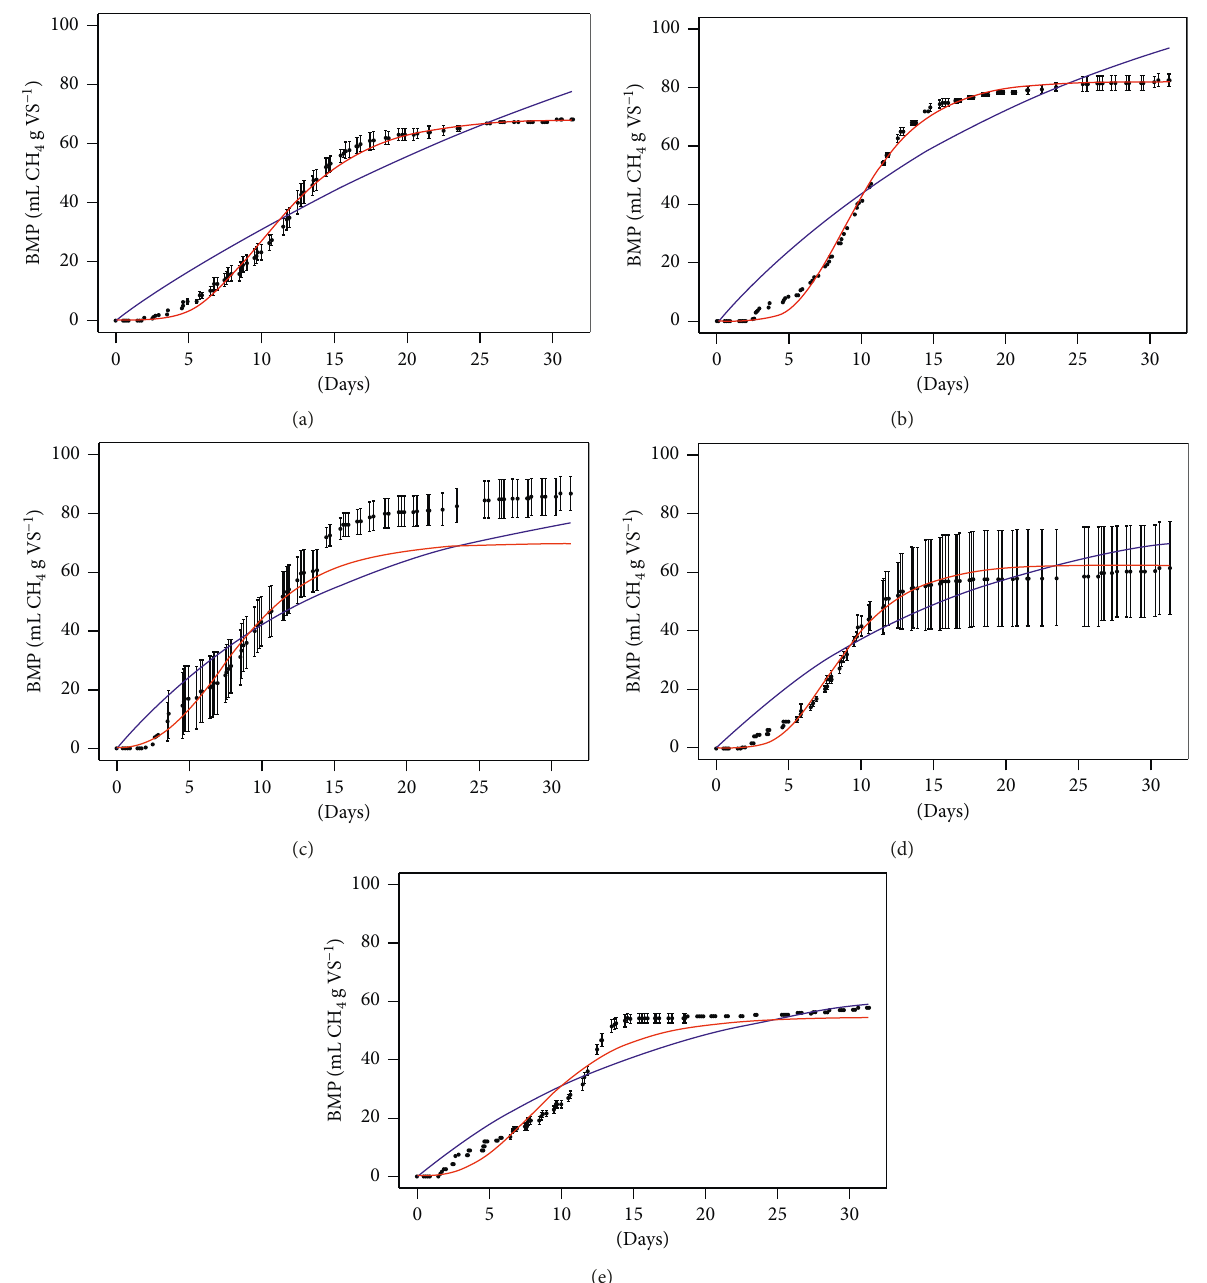
Figure 1: BMP of each SPM: FW ratio: (a) 100:0; (b) 80: 20; (c) 60 :40; (d) 50: 50; (e) 0:100, and best fit to the first-order kinetic model (blue line) and the modified Gompertz model (red line). The error bars represent the experimental standard deviation between triplicates ( n �